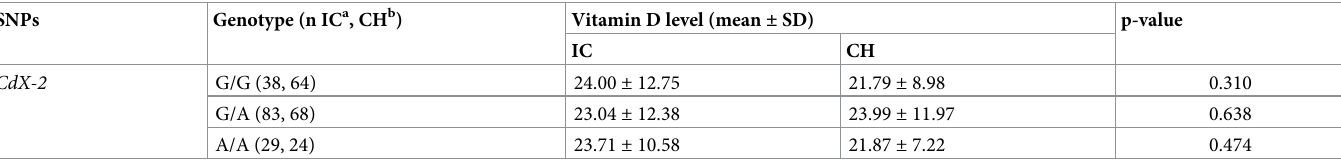
Table 3. Vitamin D levels according to CdX-2 genotypes in HBV inactive carrier and chronic hepatitis